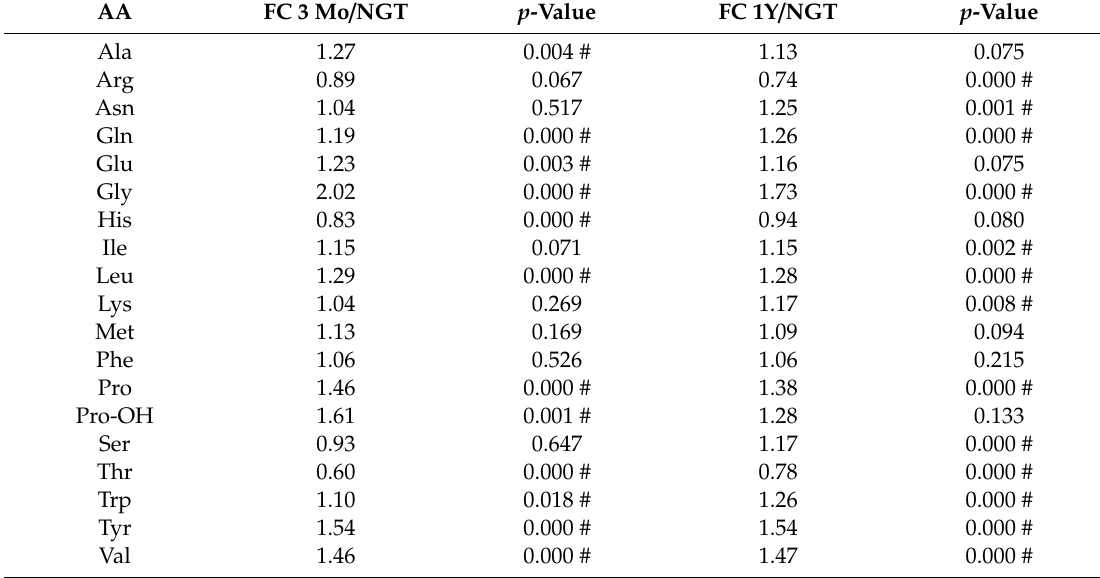
Table 5. Amino acids concentrations ( µ M / L) in plasma of studied patients in follow-up GDM group compared to NGT group.